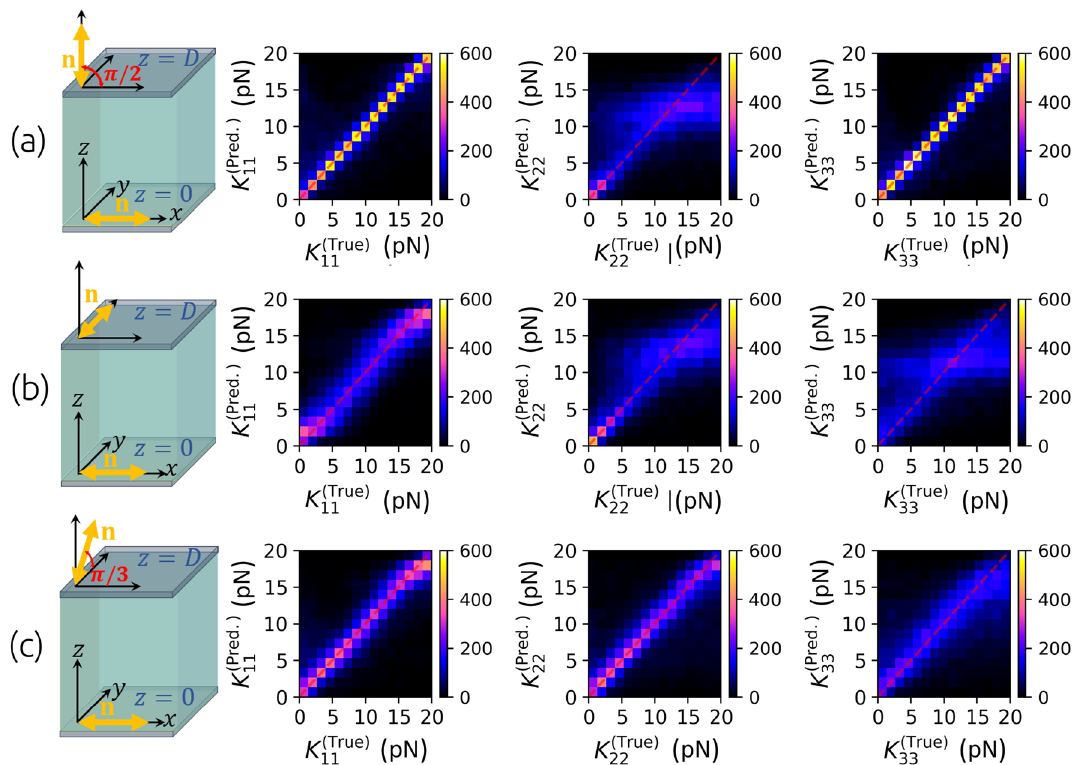
Figure 7. Prediction of all three elastic constants from I ( t ) measured through samples with 3D director with 1D dependence, n ( z , t ) = ( n x ( z , t ) , n y ( z , t ) , n z ( z , t )) . Comparison of predicted and actual elastic constants K 11 , K 22 , K 33 from the numerical validation data sets with different anchoring combinations, marked by two-headed arrows in the first column. While in the hybrid-aligned nematic (HAN) cell ( a ), it is possible to determine K 11 and K 33 , in the twisted nematic (TN) cell ( b ), only K 11 can be roughly predicted, but using a tilted twist nematic (TTN) cell with planar ( θ( z = 0 ) = 0 , φ( z = 0 ) = 0 ) and tilted ( θ( z = D ) = π/ 3 , φ( z = D ) = π/ 2 ) anchoring ( c ), it is achievable to extract all three constants from the time-dependent transmittance I ( t ) at